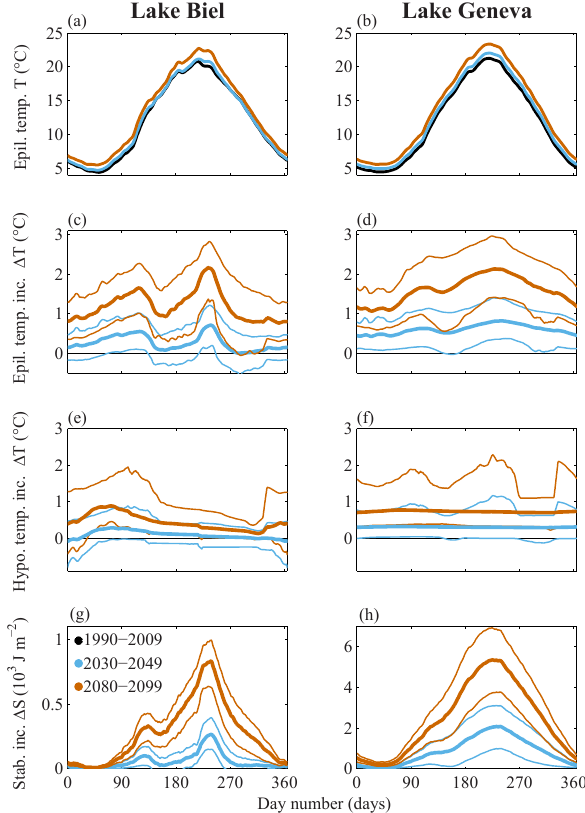
Figure 7. Modeled climate impact from scenarios LB3 (LB; a , c , e , g ) and LG3 (LG; b , d , f , h ) displayed as daily mean (thick lines) and maximum/minimum model values (thin lines) for near-future (blue, 2030–2049) and far-future (orange, 2080–2099) relative to the reference period (black, 1990–2009). Anthropogenic MNPP heat input entering LB has been excluded from near-future and far-future time periods but retained for the reference period. Temperature T ( a and b ), increase in temperature (cid:49)T in epilimnion ( c and d ) and hypolimnion ( e and f ) as well as increase in stability (cid:49)S ( g and h ).